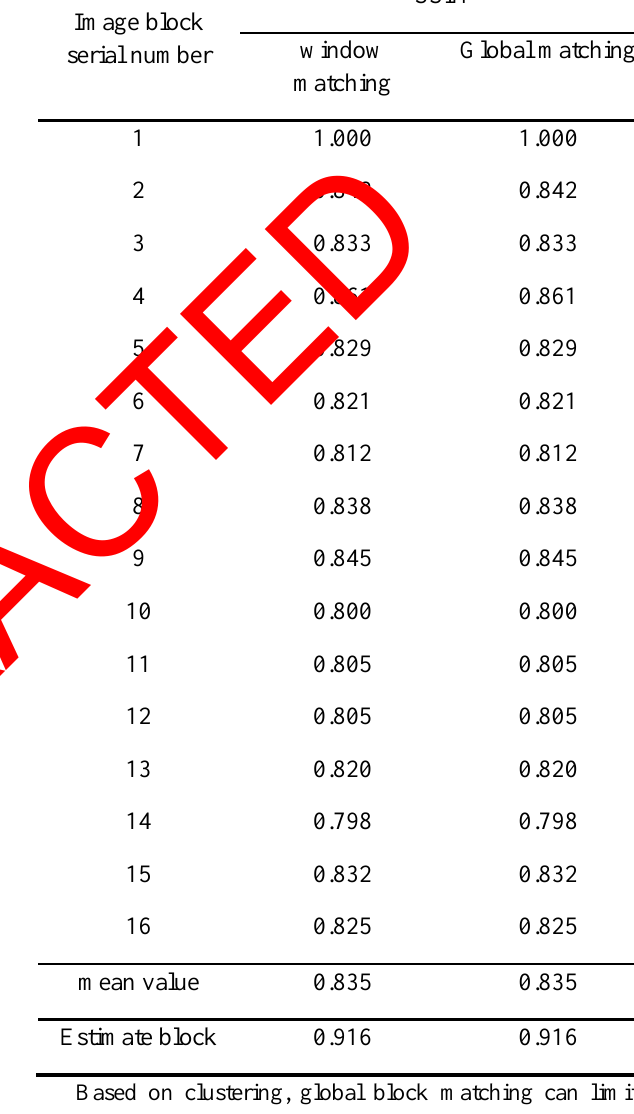
Figure 2. Global block matching compared with window block matching